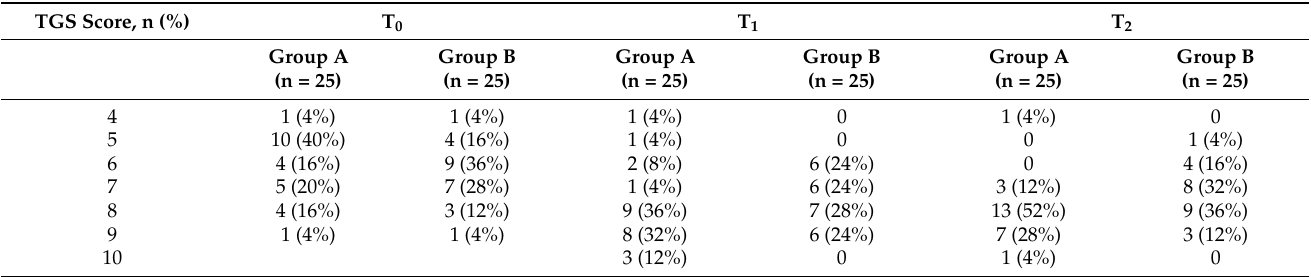
Table 2. Results of the Tinetti Gait Scale (TGS).